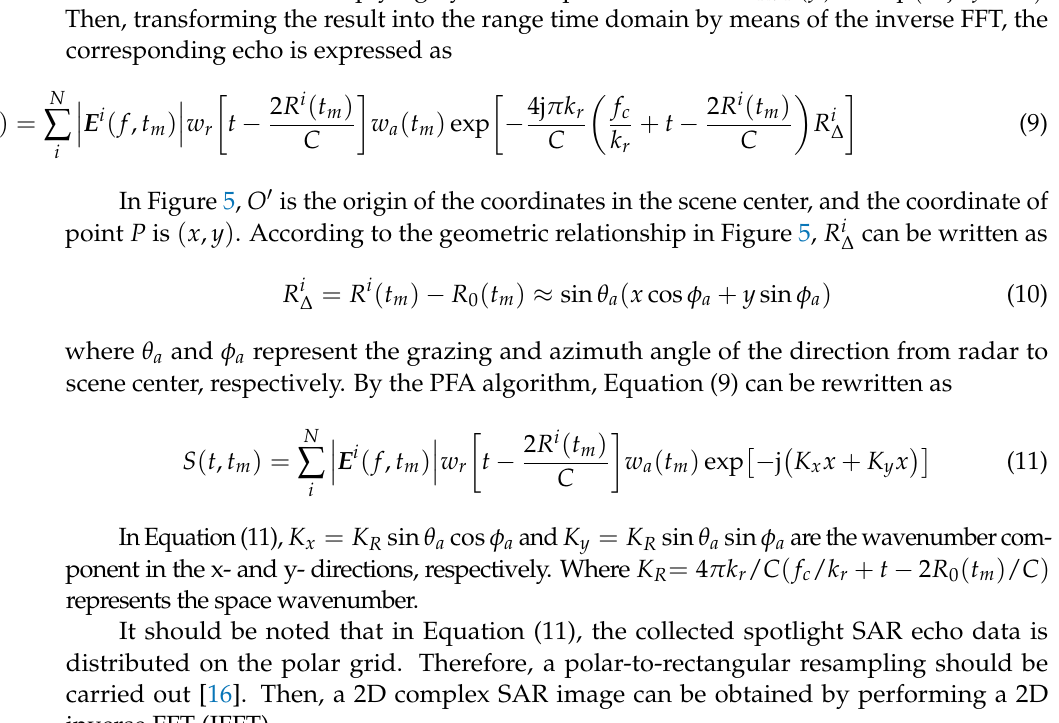
(cid:0) − (cid:1) j π f 2 / k r .